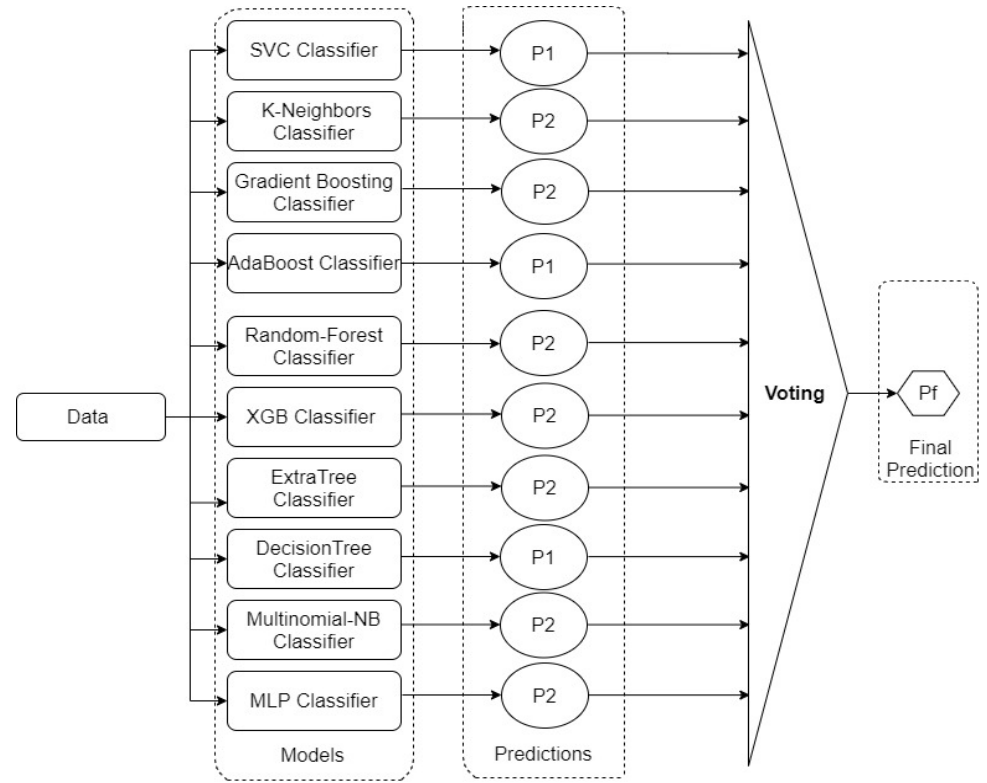
Figure 8. Model of Ensemble Vote as majority voting.